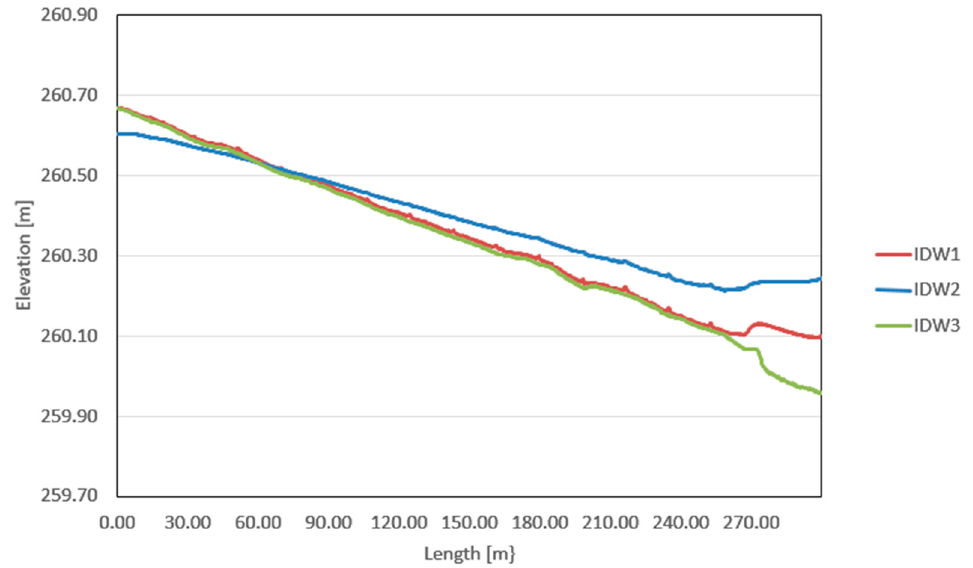
Figure 5. Modelling of the longitudinal cross section P2 using selected IWD methods.